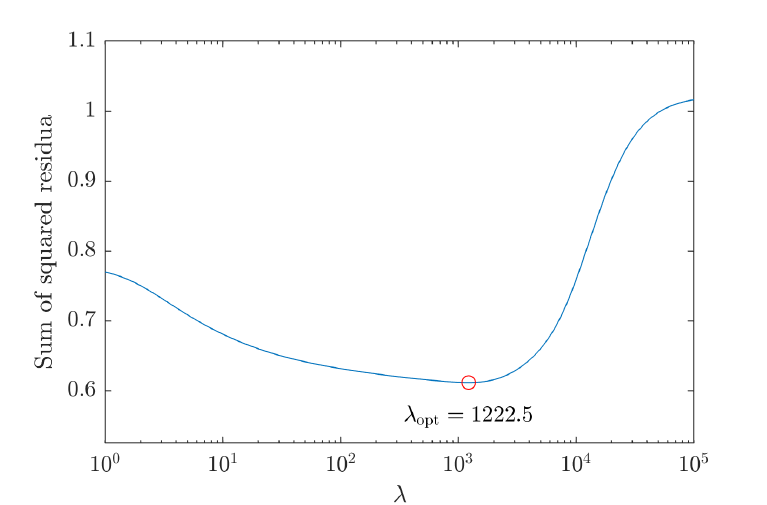
Figure 2. Sum of squared residua over λ . The minimum defines the optimum λ value that is used for the reconstructions.